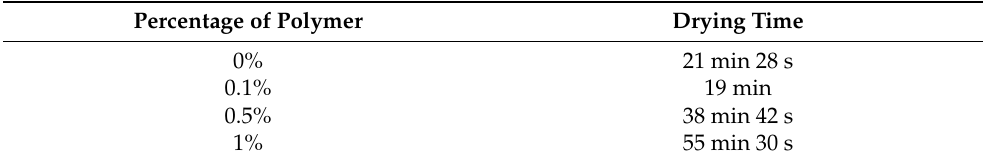
Table 4. Results of drying time of individual samples.